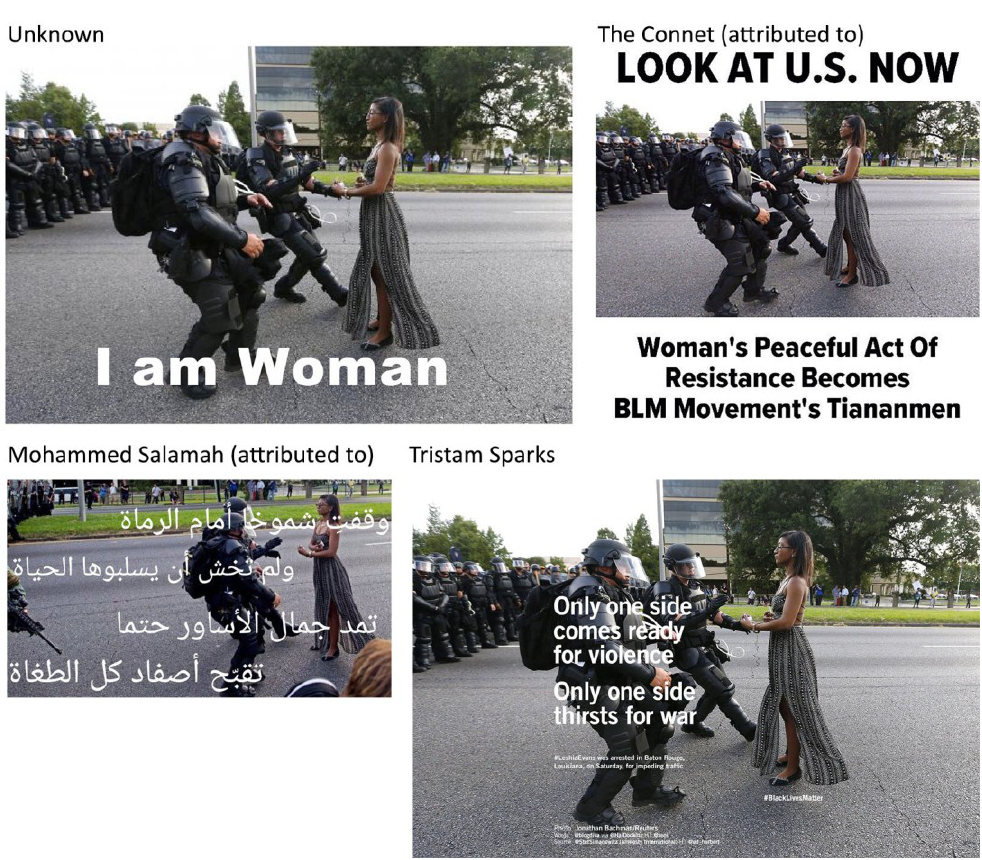
Figure 4. Textual overlays. Source: Twitter.